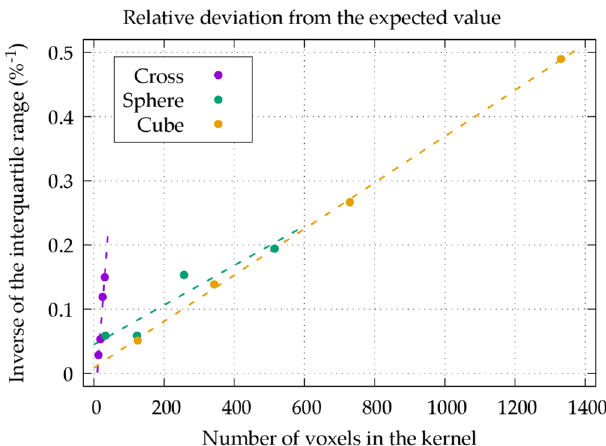
Figure 5. Trend of the inverse of the dispersion, quantified through the interquartile range, of the mean electric conductivity values estimated with the phase-based Helmholtz-EPT under repeatability conditions with respect to the number of voxels in the kernel of the Savitzky–Golay filter.